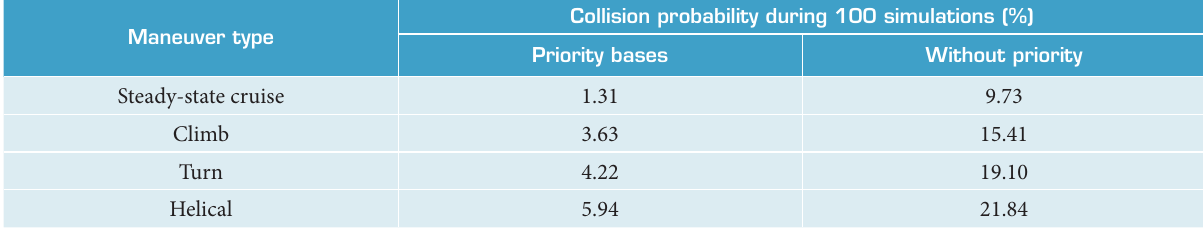
Table 5. Collision probability in different maneuvers according to